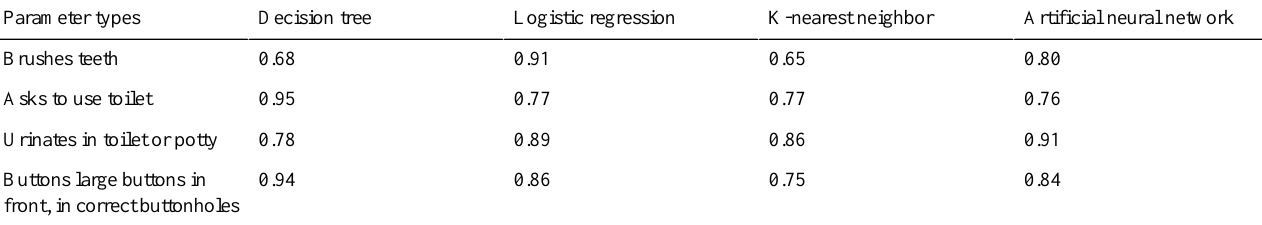
Table 6. Summary of receiver operating characteristic–area under the curve for all prediction models based on demography for "daily living skills."